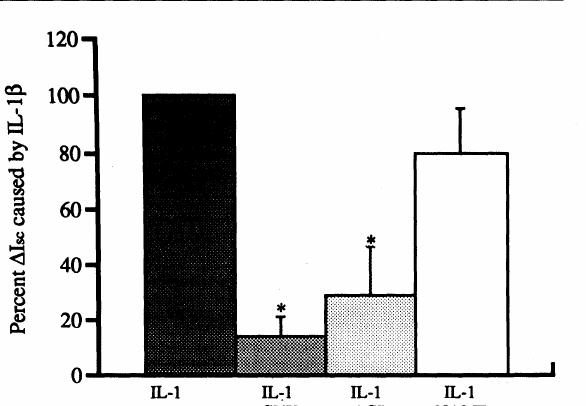
FIG. 5. The effect of IL-11 on short-circuit current alone and in the presence of cycloheximide (CYX, 100 lg/ml), actinomycin D (ACD, 10 lg/ml) and NAME (500 M). The data (mean +/- S.E., n 5, *p < 0.05. p value represents the comparison of the IL-1 on short-circuit current in the pres- ence of the inhibitor to its effect alone) are presented as percentage change in short-circuit current caused by IL-I. The effect of TNFc on Isc in rabbit distal colon: We action of TNF to that observed by IL-1. TNF at